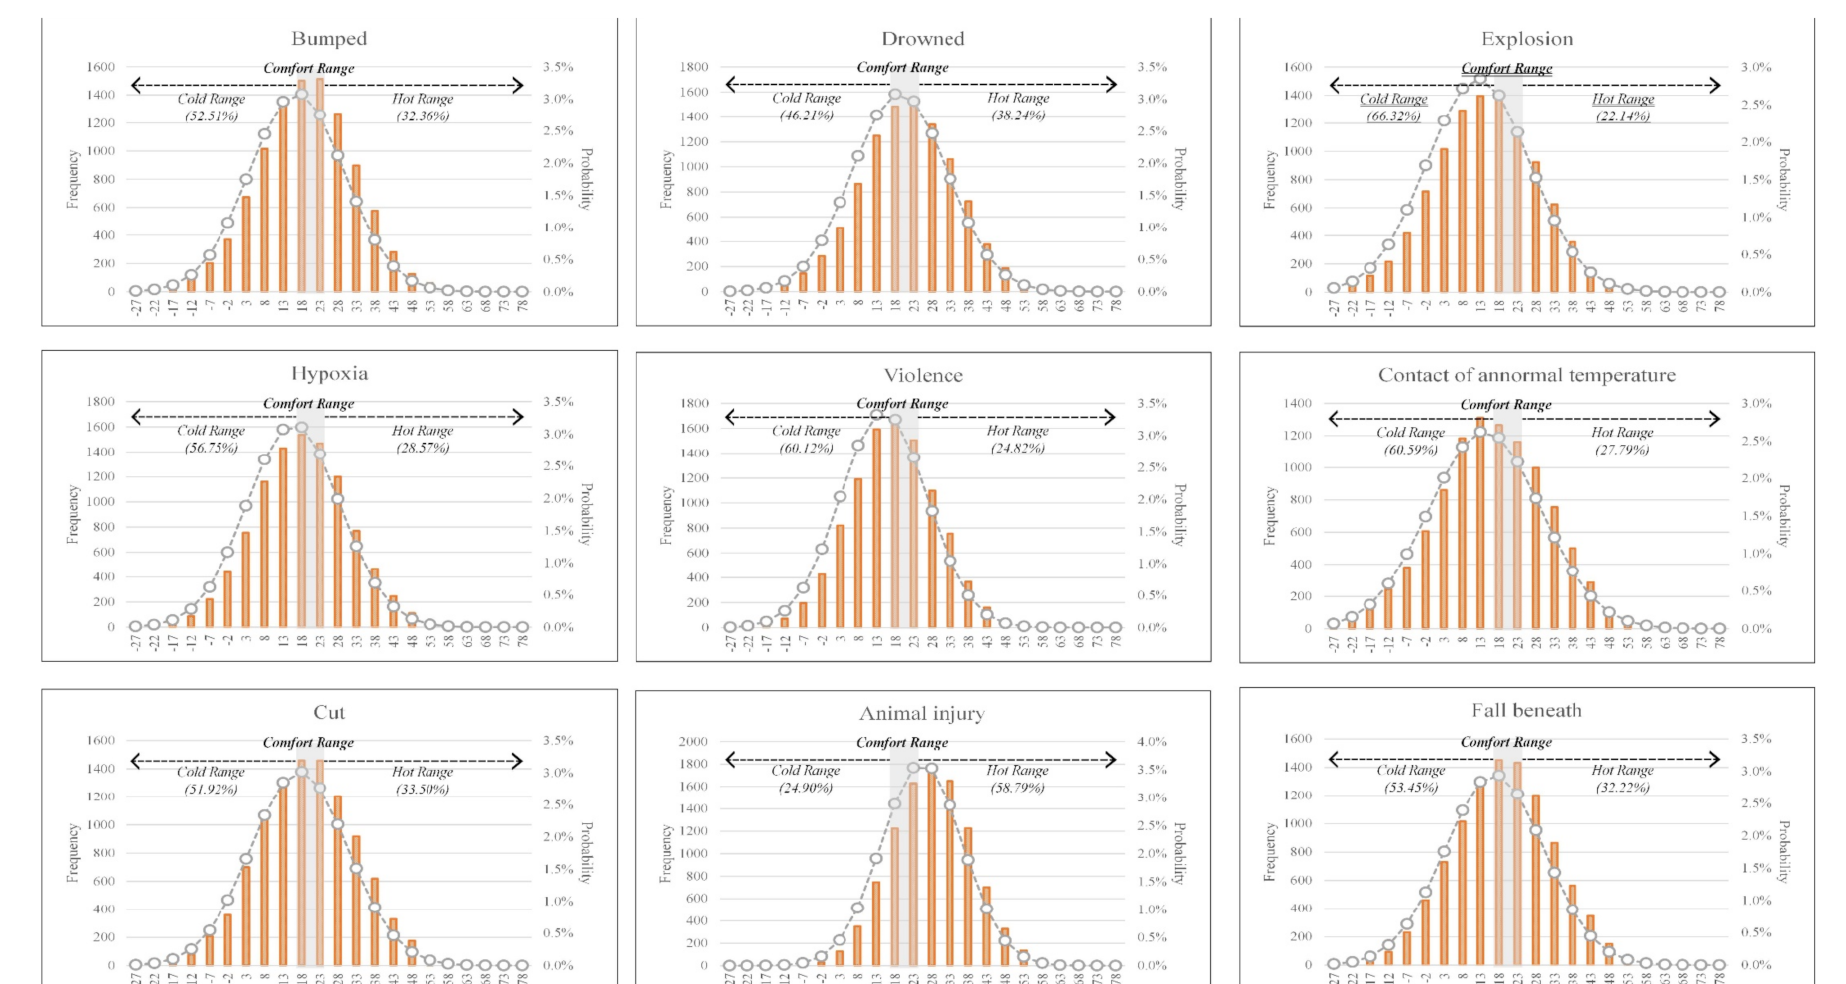
Figure 8. Analysis of the probability distribution of injuries using a Monte Carlo